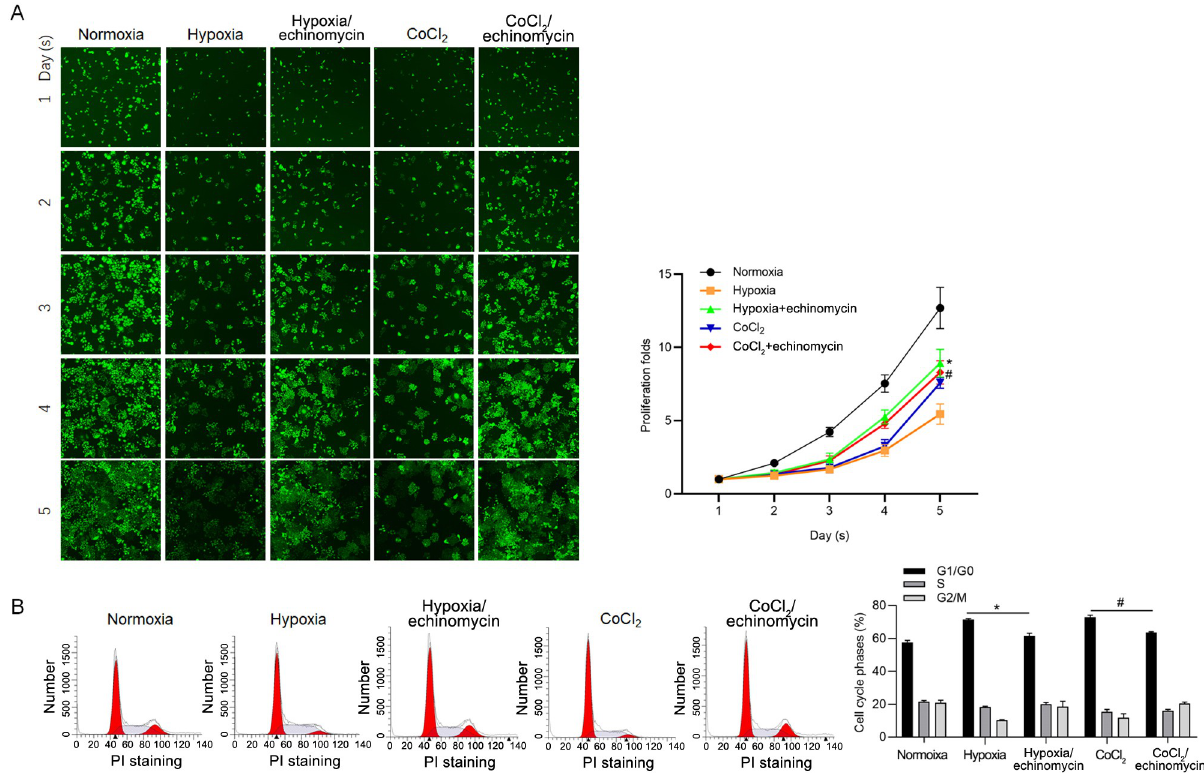
Fig 2. The effect of transcriptional activity of HIF-1 α on proliferation. A. Cell viability was measured by performing high content screening (HSC)- based assay. B. Cell cycle distribution was analyzed by PI staining followed by flow cytometric assay. � P < 0.05, vs. hypoxia group; #P < 0.05, vs. CoCl 2